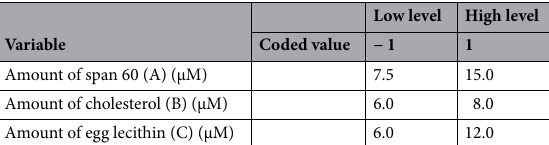
Table 1. Actual and coded levels of variables.